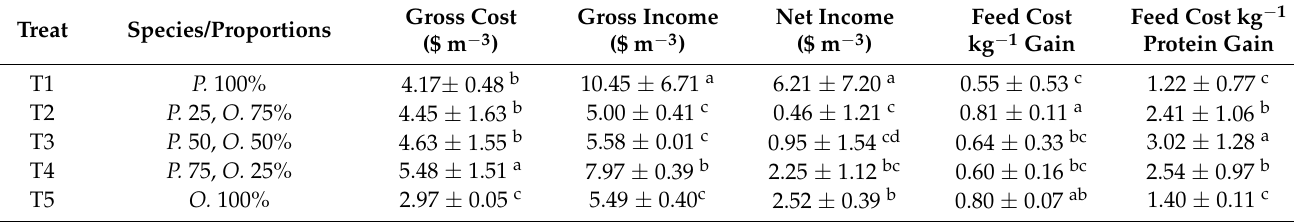
Table 4. Economical evaluation of juvenile striped catfish, Pangasianodon hypophthalmus (P.), and Nile tilapia, Oreochromis niloticus (O.), reared in monoculture and polyculture proportions for 14